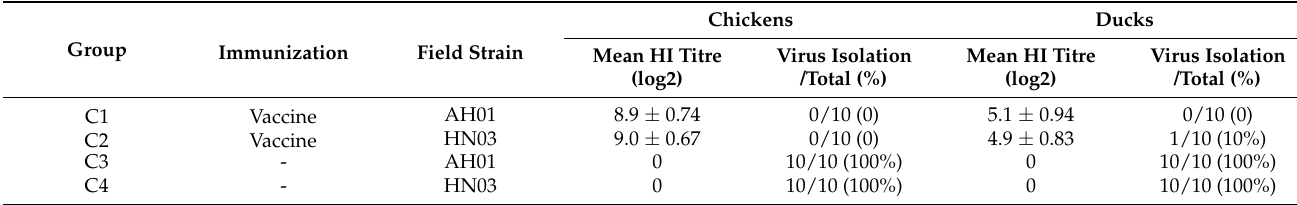
Table 4. Evaluation of cross-protective efficacy of vaccine against H9N2 viruses.